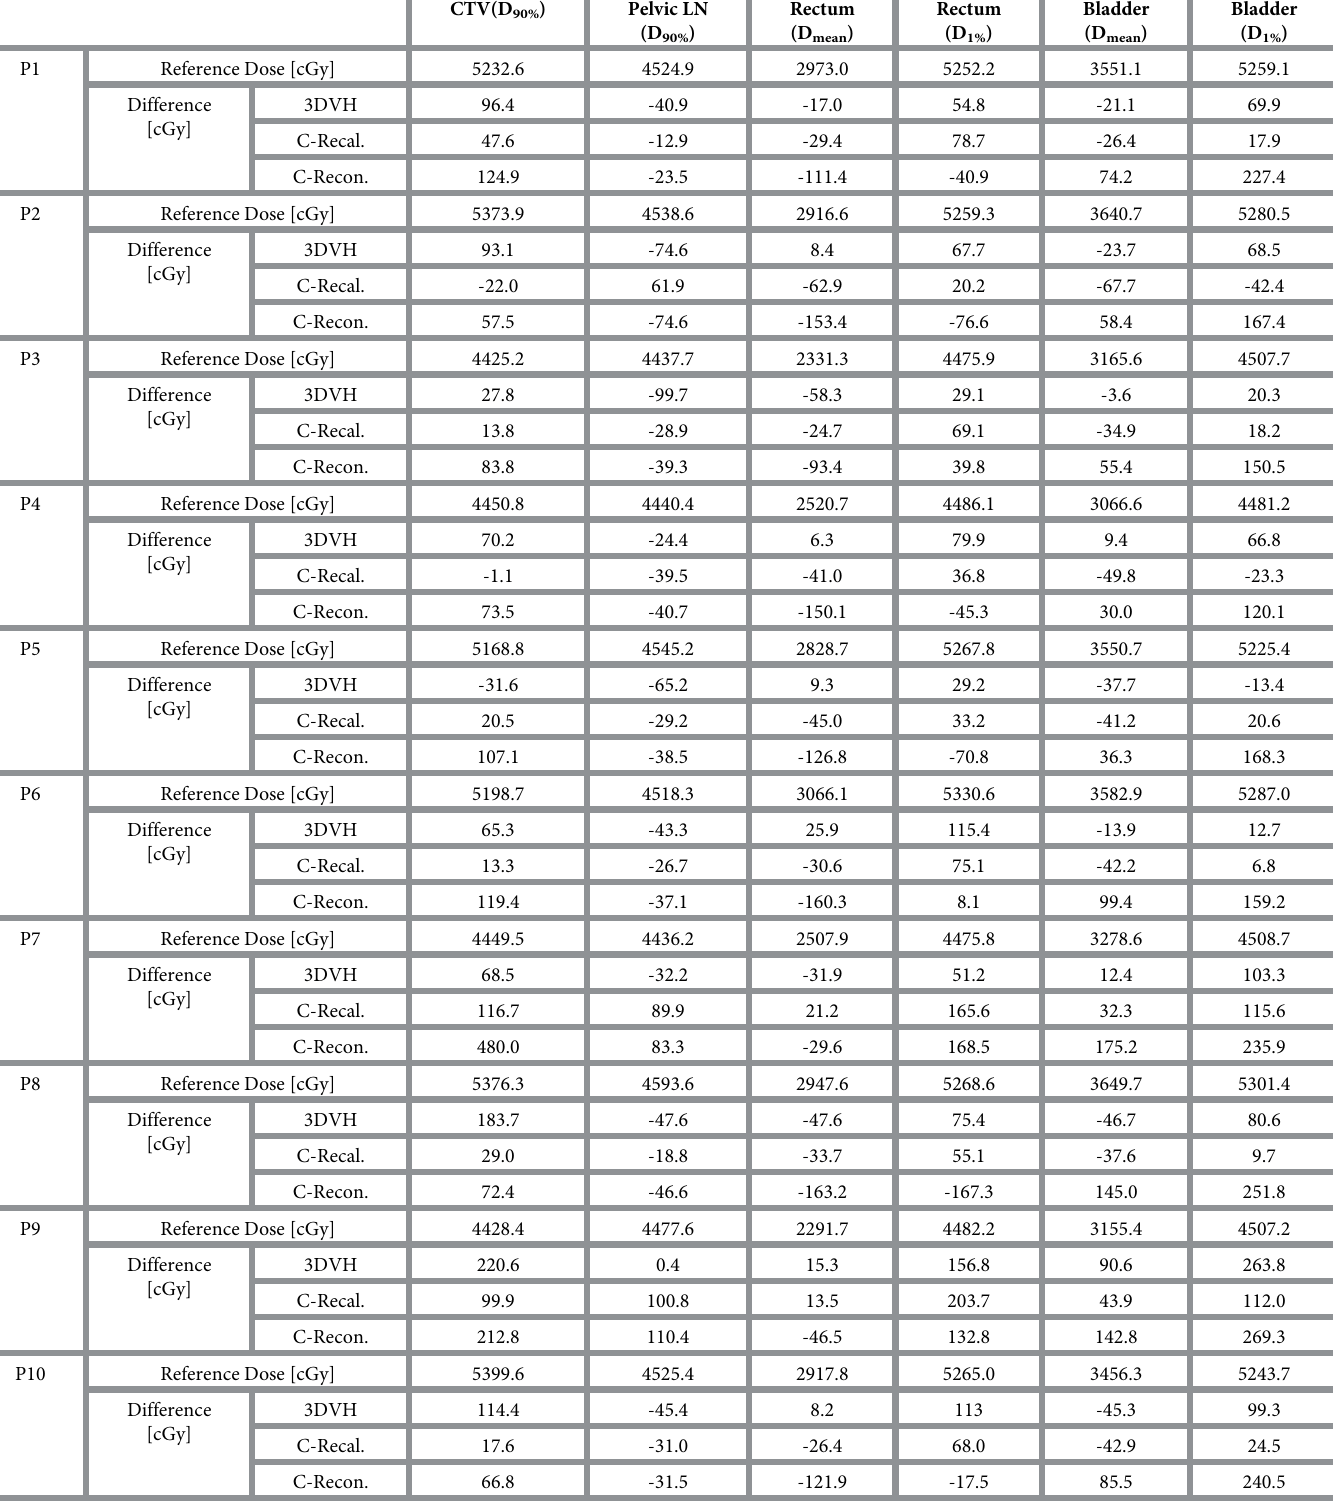
Table 8. Differences in dose metrics of tumor target and OARs calculated using 3DVH and compass (C-Recal.: Compass Recalculation, C-Recon.: Compass Recon- struction) for the Prostate plans compared with a reference dose calculated using Eclipse